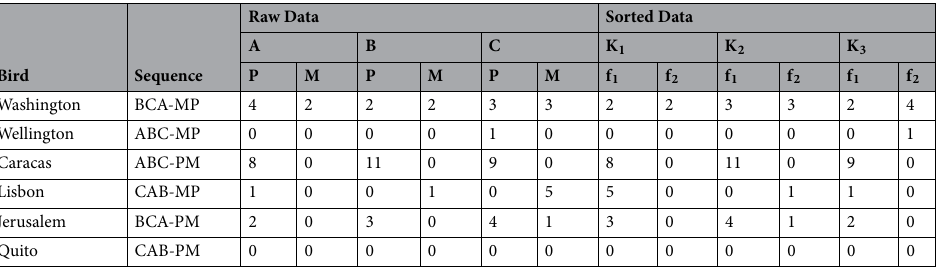
Table 1. Number of items cached in Experiment 1. Raw data and semantically sorted data (K1 = compartment available on trials 1, 4, 7; K2 = compartment available on trials 2, 5, 8; K3 = compartment available on trials 3, 6, 9; f1 = food received on trials 1, 3, 5, 7, 9; f2 = food received on trials 2, 4, 6, 8). The entries in the Sequence column indicate the temporal order of compartments and food type during the experience phase, e.g., BCA-MP means that the bird was in compartment B on trials 1, 4 and 7 and received macadamia nuts (M) on trials 1, 3, 5, 7 and